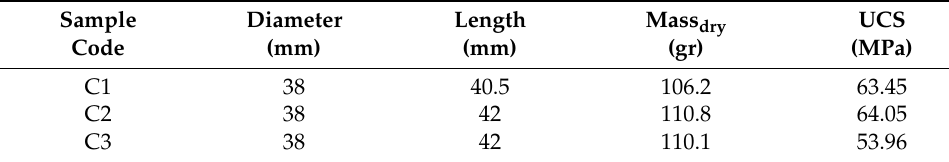
Table 1. UCS values obtained for Low-porosity sandstone samples.